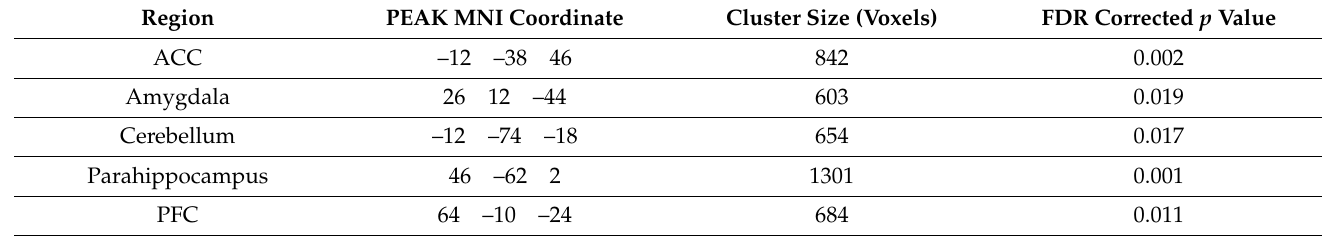
Table 4. Coordinates of the largest cluster size for each respective ROI for functional connectivity analysis (ACC = anterior cingulate cortex, PFC = prefrontal